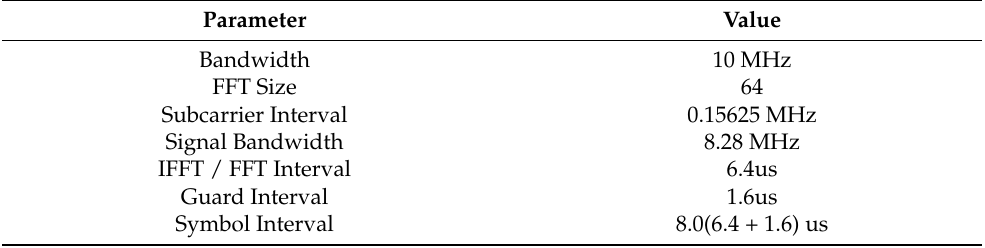
Table 1. Properties of OFDM signal in IEEE 802.11p.